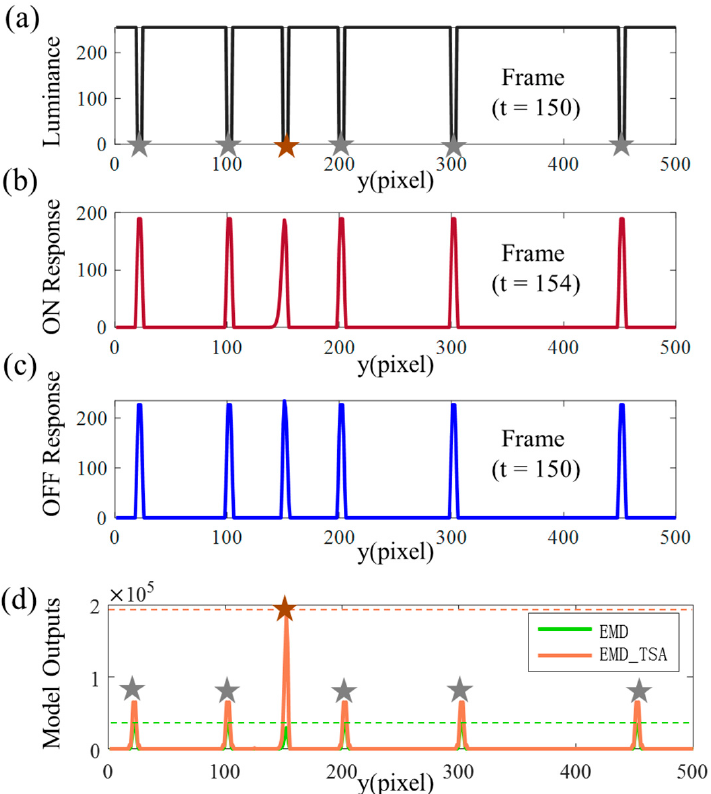
Figure 5. Outputs of various layers in the proposed model for moving target with flashed false targets in space. ( a ) The input luminance signal I ( x 0 , y , t 0 ) . ( b ) ON response S ON of the proposed model. ( c ) OFF response S OFF of the proposed model. ( d ) The outputs of EMD (green line) and EMD_TSA (yellow line). The red asterisk marks the position of the moving target, and the gray asterisk marks the position of flashed false targets. The green dashed lines indicate the peaks of the EMD outputs, while the yellow purple dashed lines correspond to the peaks of EMD_TSA outputs.